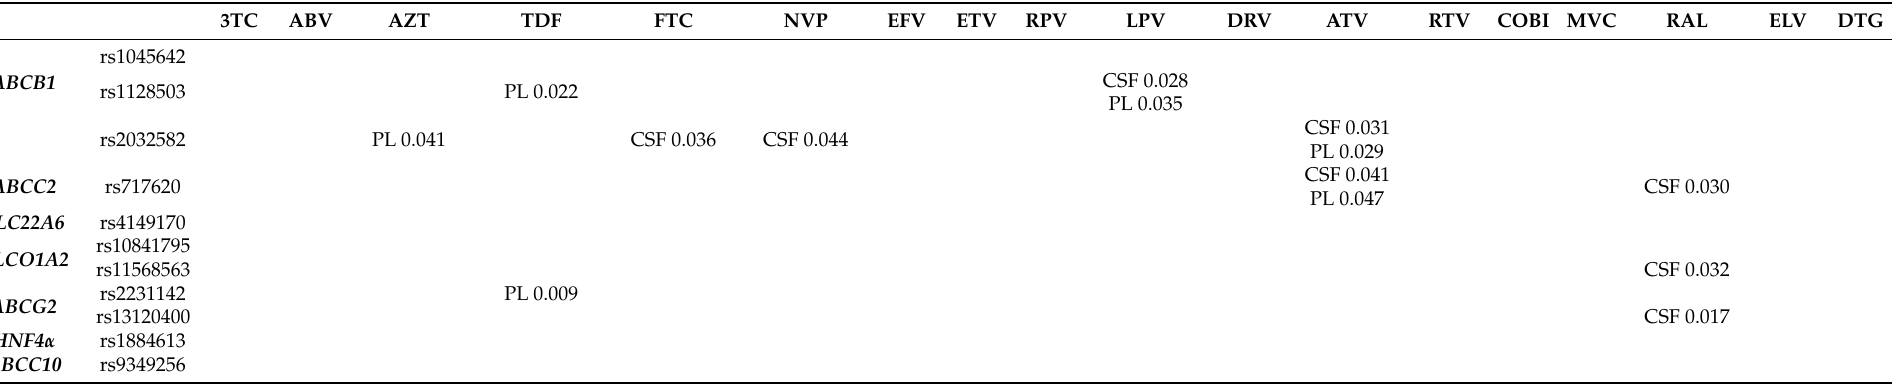
Table 2. Influence of single-nucleotide polymorphisms on plasma (PL) and cerebrospinal fluid (CSF) drug concentrations. BBB and altered neopterin were associated ( p = 0.003, Pearson coefficient